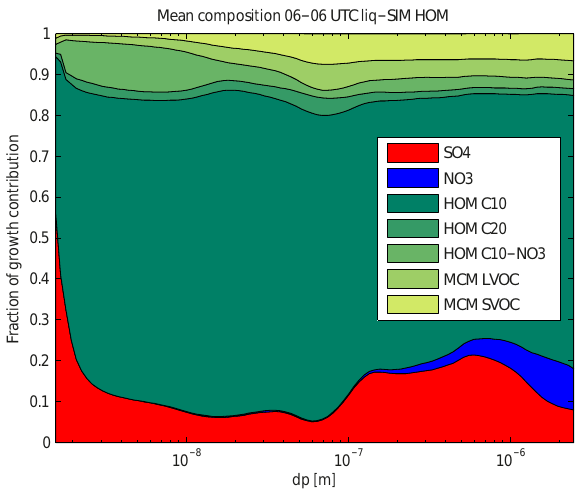
Figure 7. Mean mass fractions of each compound type that con- tributes to the growth of the particles during all chosen new particle formation events from the base-case simulations (from 06:00UTC the morning of the event to 06:00UTC the following